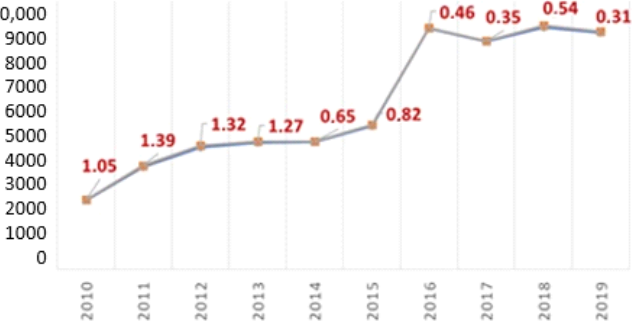
Figure 3. Percentage of positive tests over 10 years (general data). Table 3. Percentage of positive tests in the analyzed categories of worker populations per year.